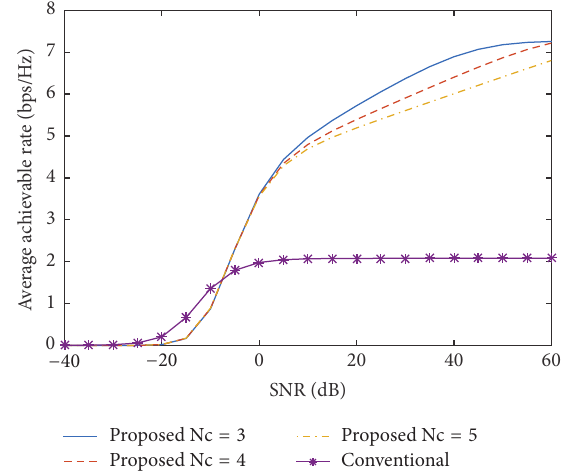
Figure 3: Average achievable rate comparison versus different Nc ( 𝑇 = 15, 𝐷 = 3 , and 𝐾 = 3 ).